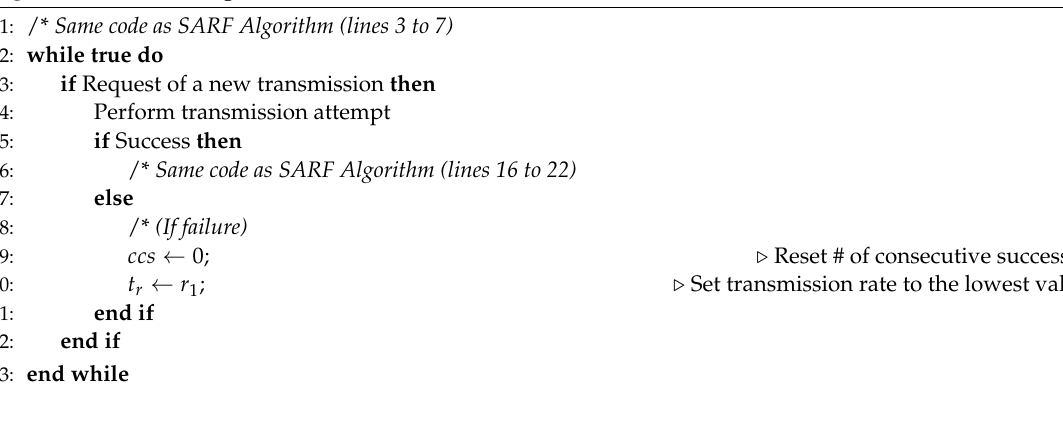
Algorithm 2 FARF